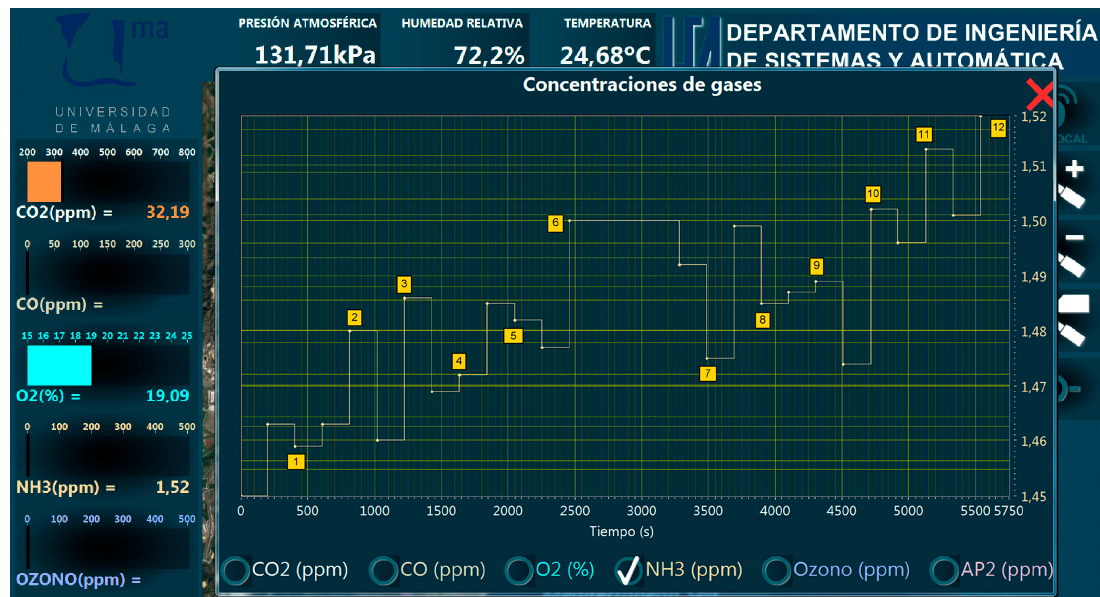
Figure 13. Area of the city of Malaga covered by experiments in networked mode.